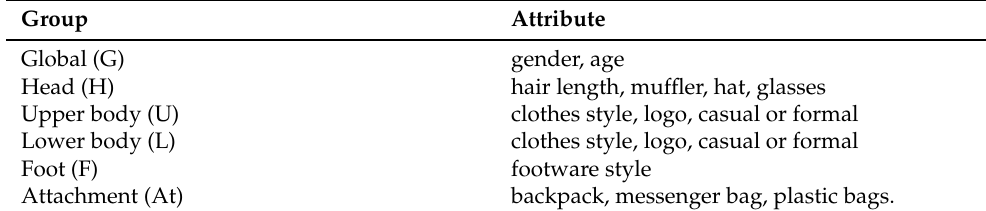
Table 2. Attribute categorization on PETA dataset.